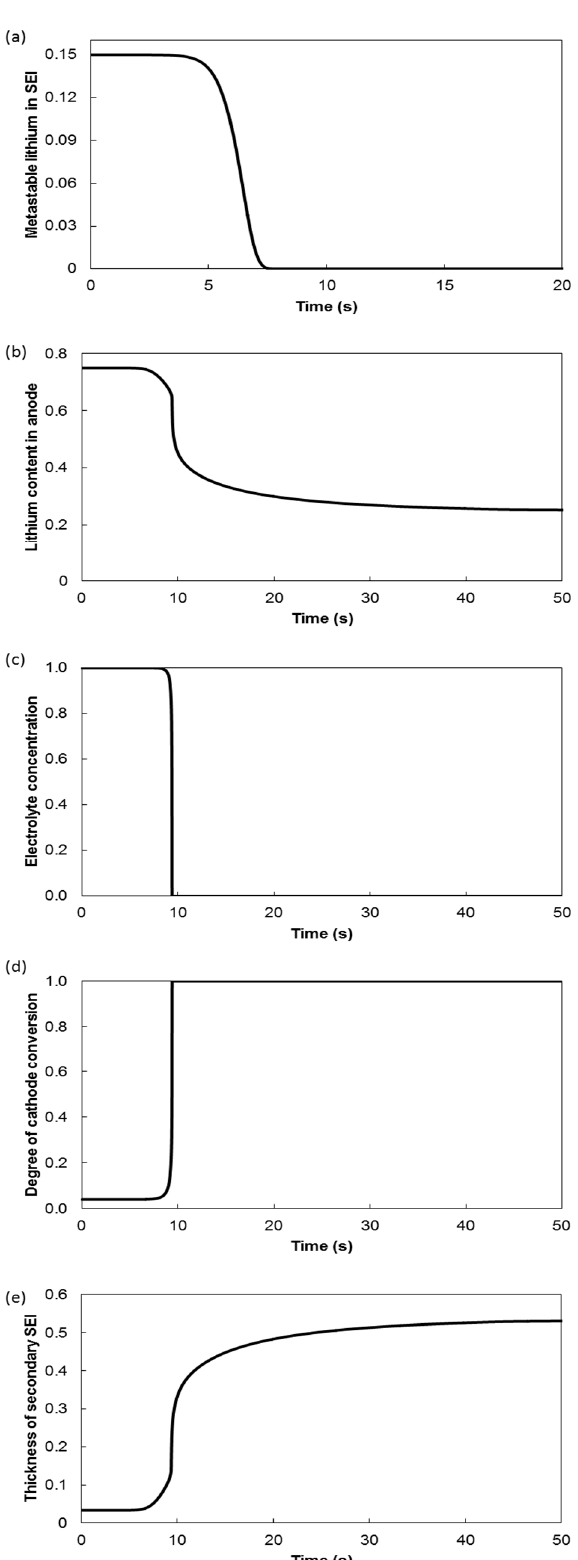
Figure 14. The progress of reaction ( a ) SEI ( b ) anode ( c ) electrolyte ( d ) cathode and ( e ) secondary SEI thickness, in Cell 1.